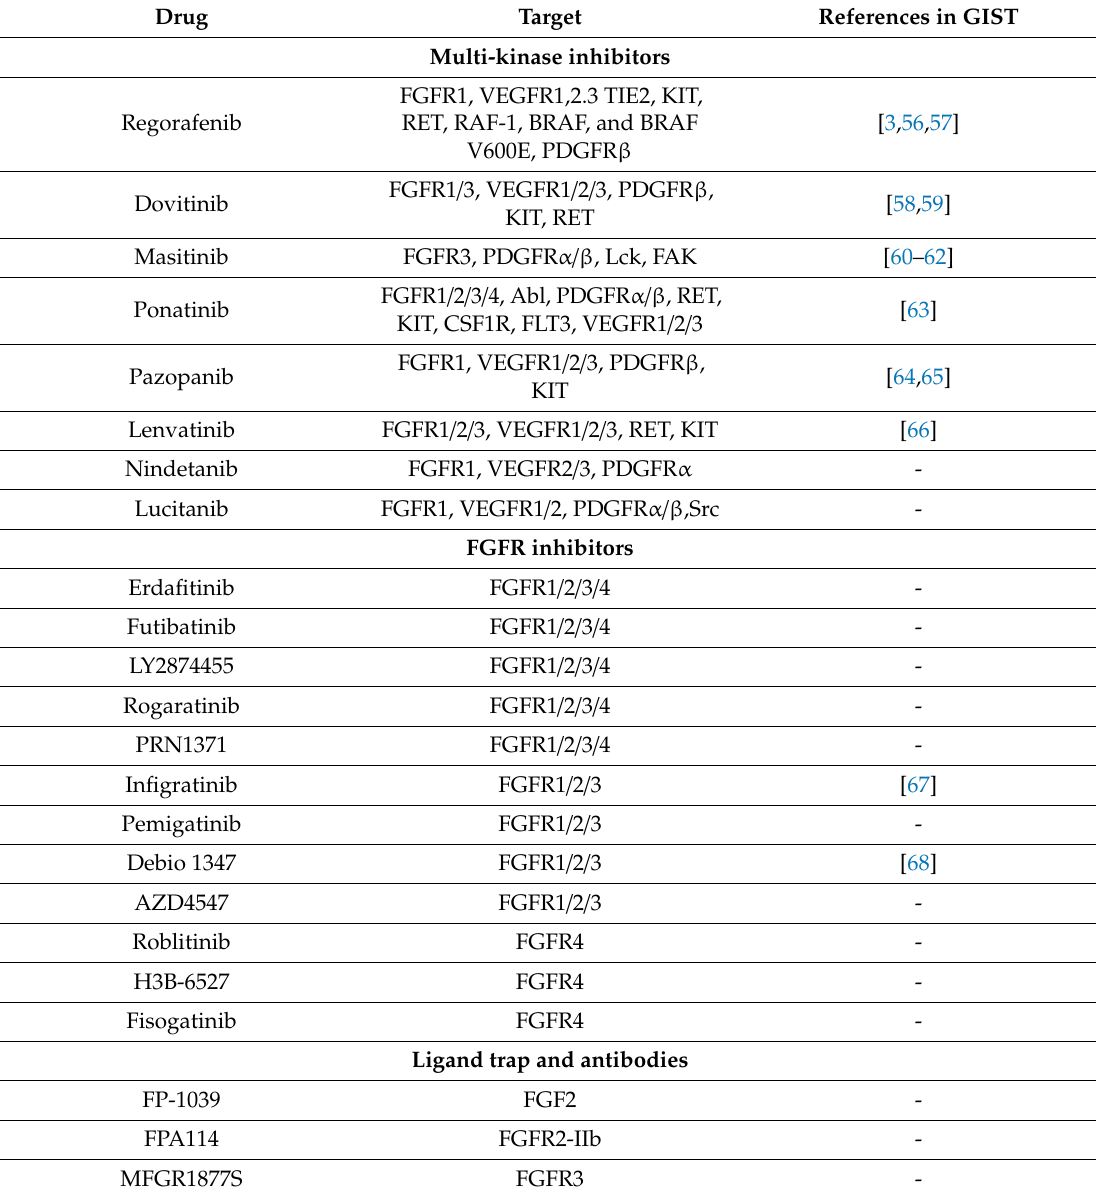
Table 2. Current status of therapies targeting the FGF signaling pathway, describing the drug type, the target specificity, and the reference of the clinical trial on